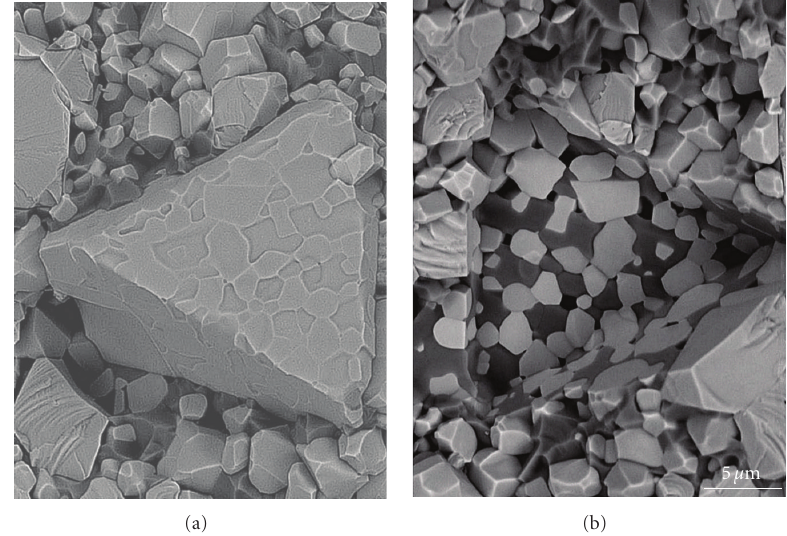
Figure 9: Fracture surface of HC10 after bending test at room temperature: abnormal grain which acted as critical defect, both the two surfaces of the bars are shown. After improving of the powder treatment, the flexural strength increased of about 100MPa and decreased the standard